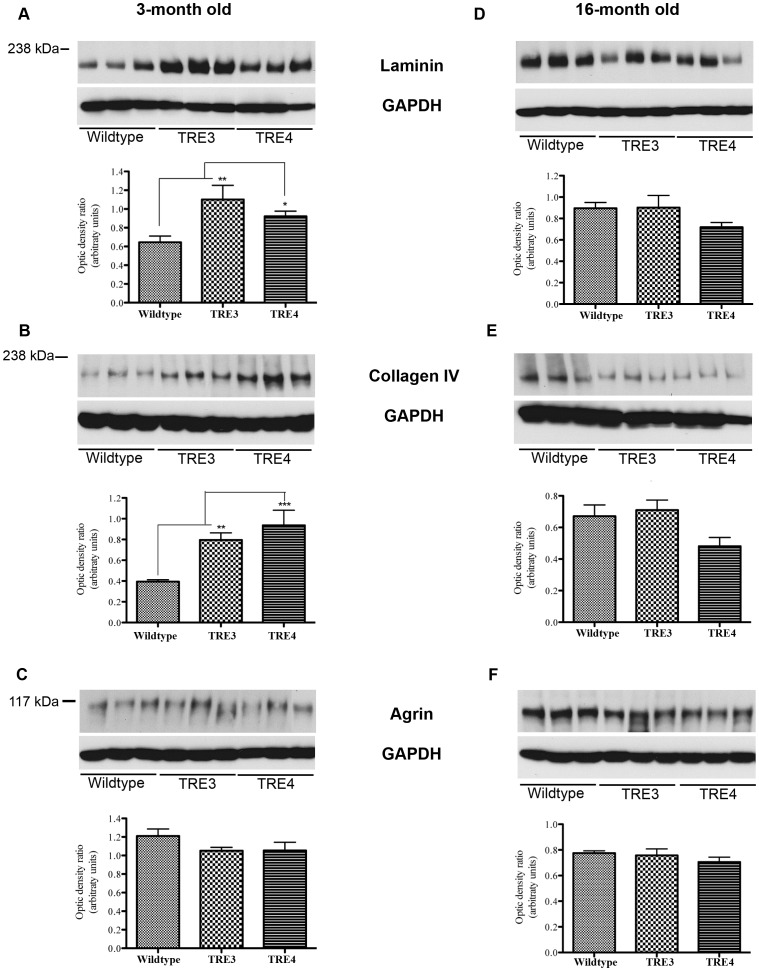
Basement membrane protein levels in the brains of 3- and 16-month old wildtype, TRE3 and TRE4 mice.Frontal-parietal brain homogenates in 3-month old (a–c) and 16-month-old (d–f) TRE3, TRE4 and wildtype controls were analyzed by Western blotting for the levels of laminin (a, d), collagen IV (b, e) and agrin (c, f). Levels of laminin and collagen IV were significantly higher in the brains of 3-month old, but not 16-month old TRE3 and TRE4 mice versus wildtype mice. Agrin levels were unchanged between wildtype, TRE3 and TRE4 mice at either age. Optic density ratios of protein to GAPDH levels from 3 blots per antibody were analyzed by repeated measures two-way ANOVA with Bonferroni post-hoc test. Histograms represent mean optic density ratio values ± S.E.M., *p<0.05, **p<0.01, ***p<0.001.